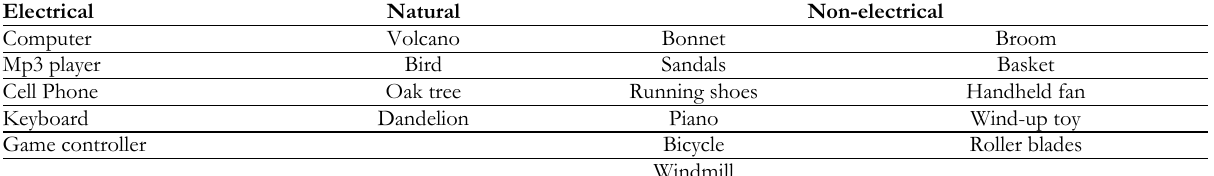
Table 7. Items in Technology and Non-technology